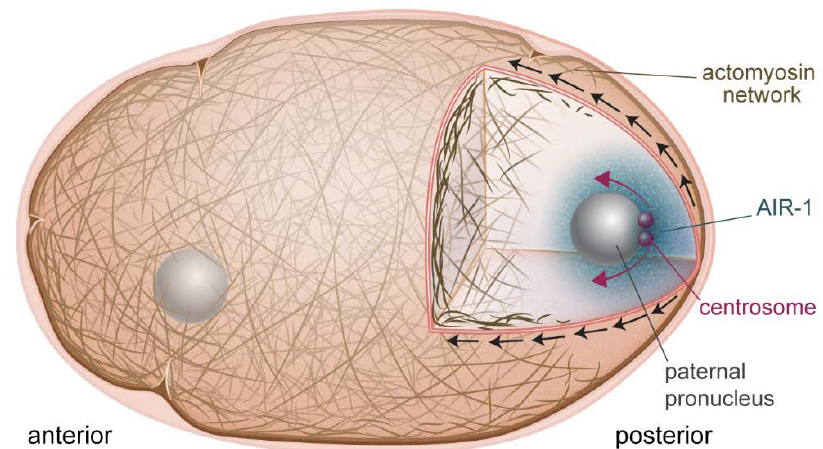
Figure 1. Symmetry breaking in the one-cell embryo. AIR-1 (blue cloud) is the cue that initiates polarization of the embryo. AIR-1 diffuses from the centrosome (red spheres) and downregulates actomyosin at the adjacent cortex. This causes a local weakening, and produces cortical flows (black arrows) directed away from this point, which also serve to separate the centrosomes (red arrows).